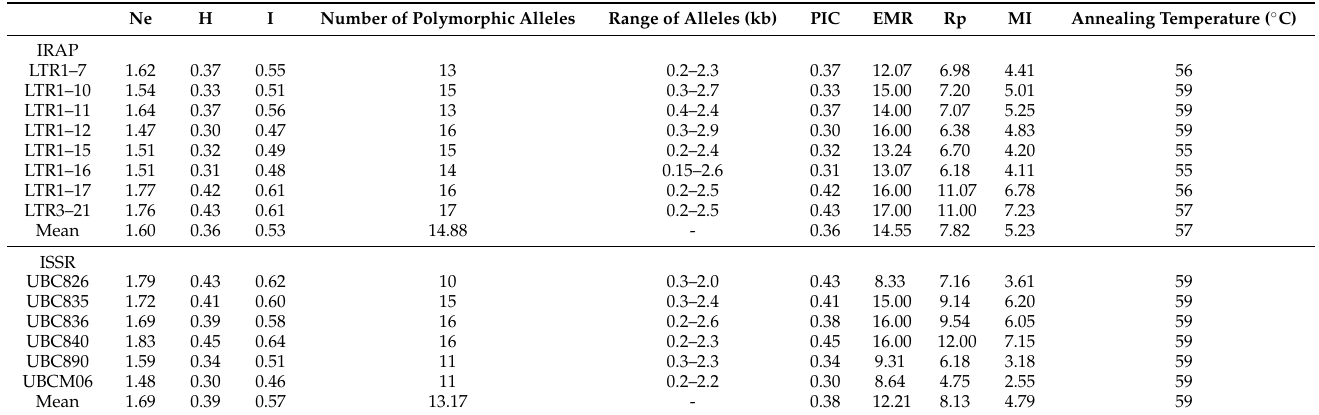
Table 1. Information content of IRAP and ISSR markers and other polymorphism indices from 46 wild rhododendron